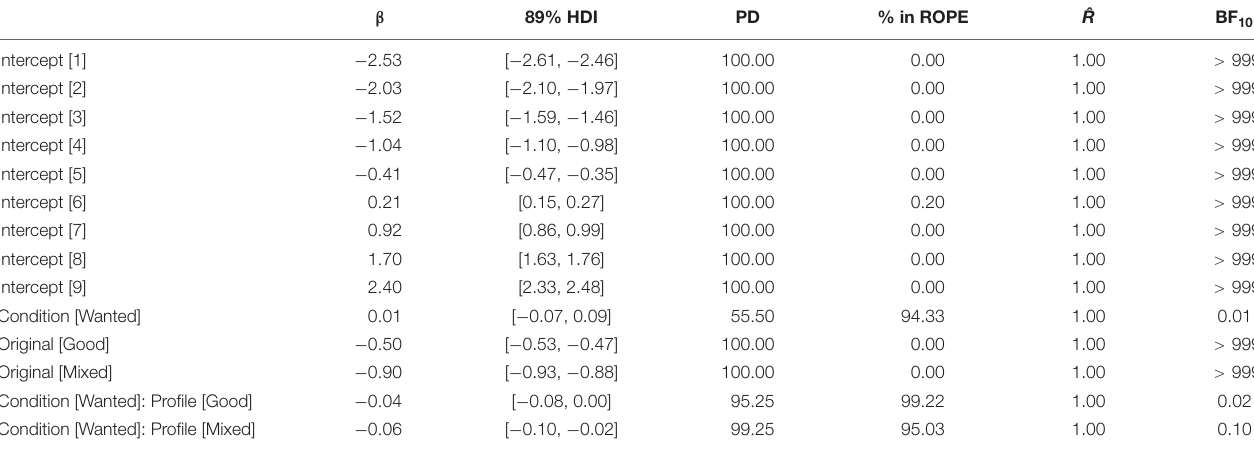
TABLE 13 | Summary of the model fitted to the sociability ratings, considering the experimental condition (Avoided or Wanted) and Profile type (Good, Mixed, and Bad).